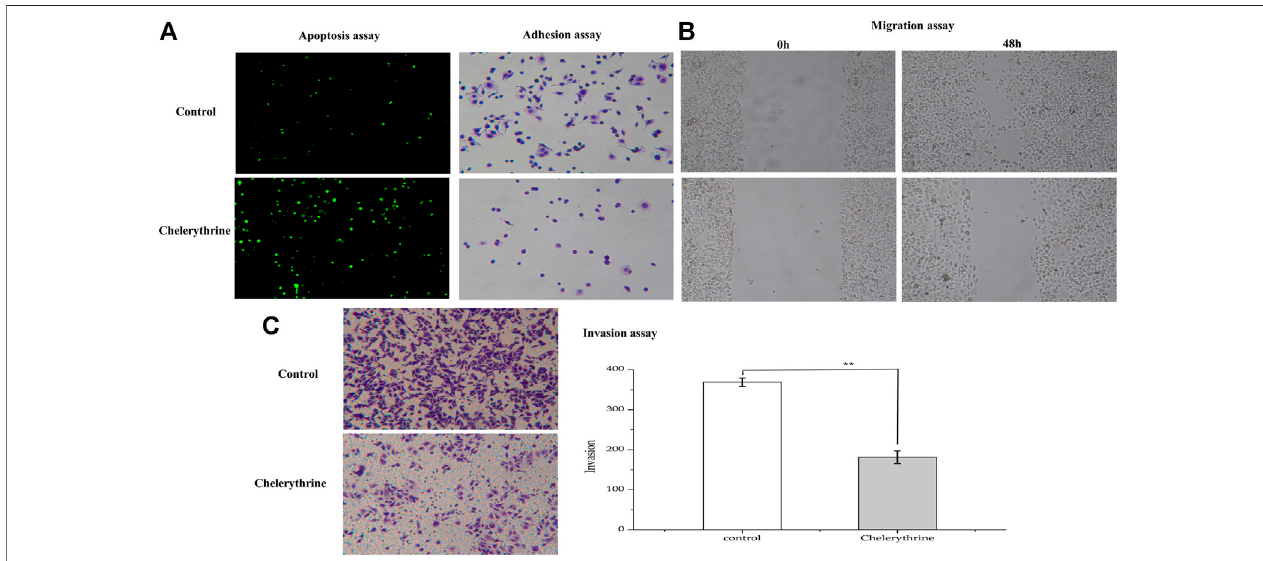
FIGURE5 | Anti-proliferative effects ofChelerythrine on Gastric cancerCells (AGS). AGS were treated with11.81 μ M Chelerythrinefor 48 h to explore its effects on adhesion,migration,invasion,and apoptosis( n =3). DMSOwasusedasnegativecontrol(Control). (A) Apoptosis andAdhesion assay. (B) Migrationassay.Images at0 and 48 h were recorded for Chelerythrine treatment and negative control groups. (C) Invasion assay. Images (left) and counts (right) of Transwell cells. **: p < 0.01.